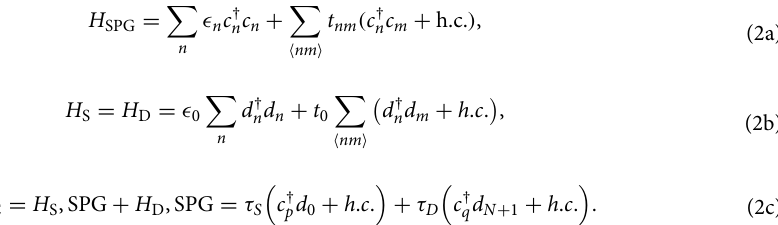
� T / 2 and T � T / 2 , where + −